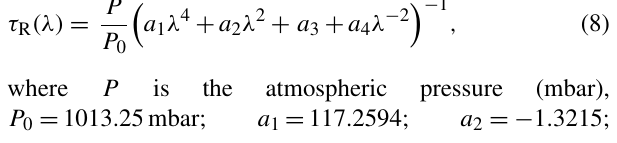
a 3 = 0.00032073; a 4 = − 0 .